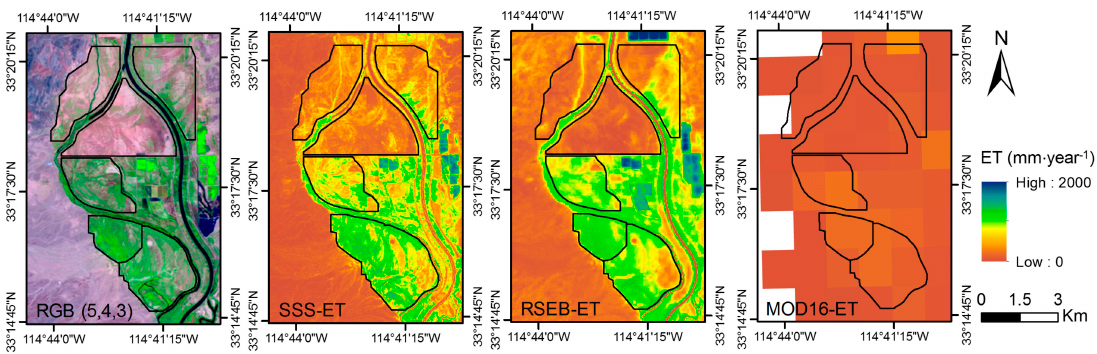
Figure 7. Annual ET based on SSS, RSEB, and MOD16 for the year 2008.